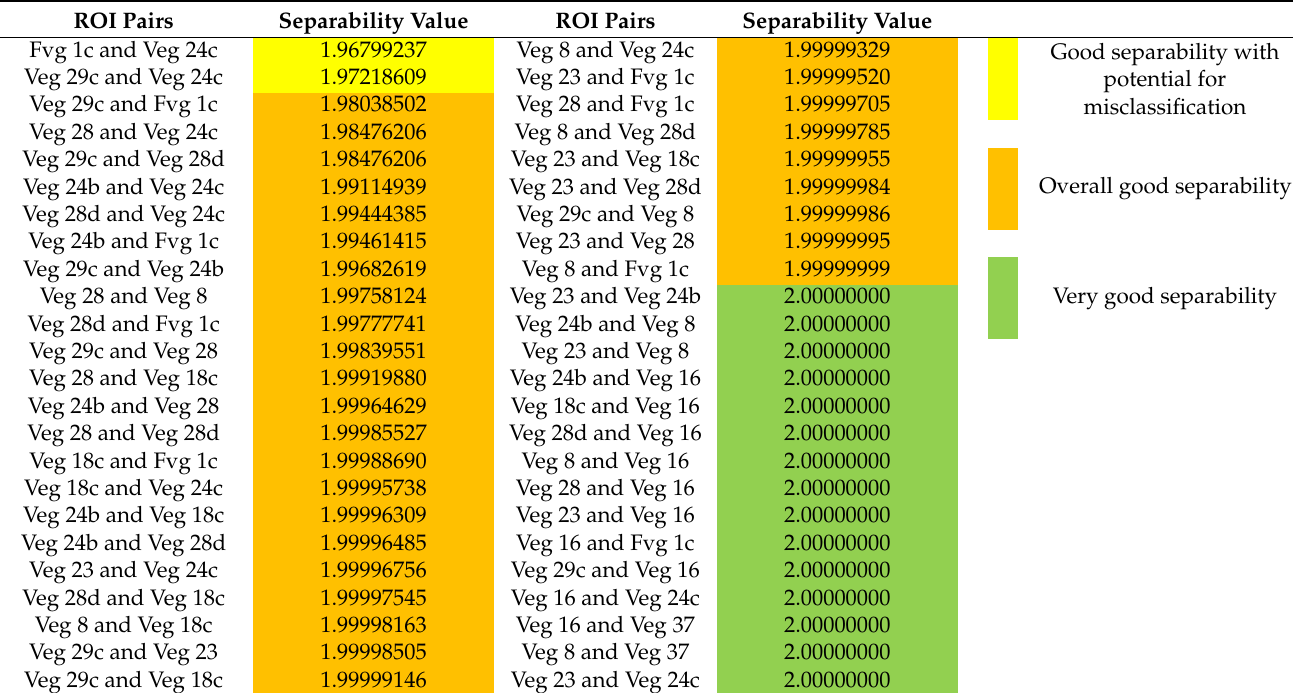
Table A2. A sample ranking of pairwise spectral ROI separability metrics for the 10 classification classes’ ROI pixels analyzed in this paper, from the lowest (in yellow) to the highest value (in green).